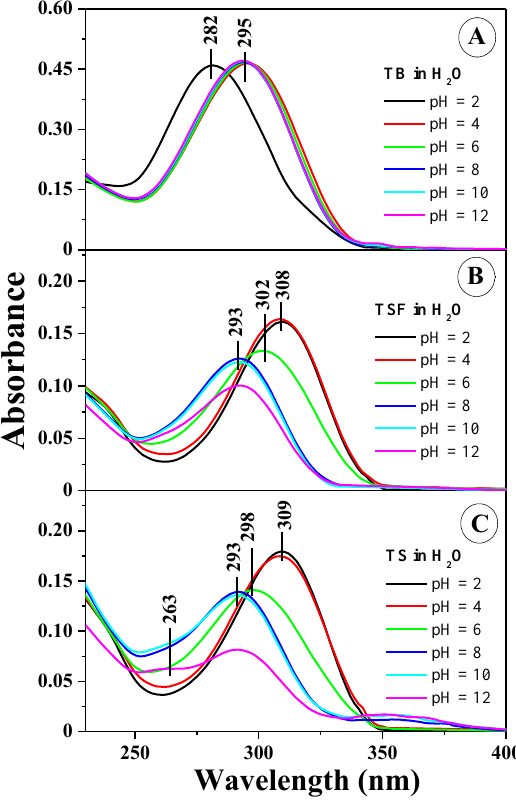
Figure 1. Absorption spectra of thiadiazoles TB, TSF and TS dissolved in H 2 O at varying pH (from 2 to 12). ( A ) TB; ( B ) TSF; and ( C ) TS. The spectra were not normalized. The absorbance intensity was adjusted to avoid the reabsorption effects.